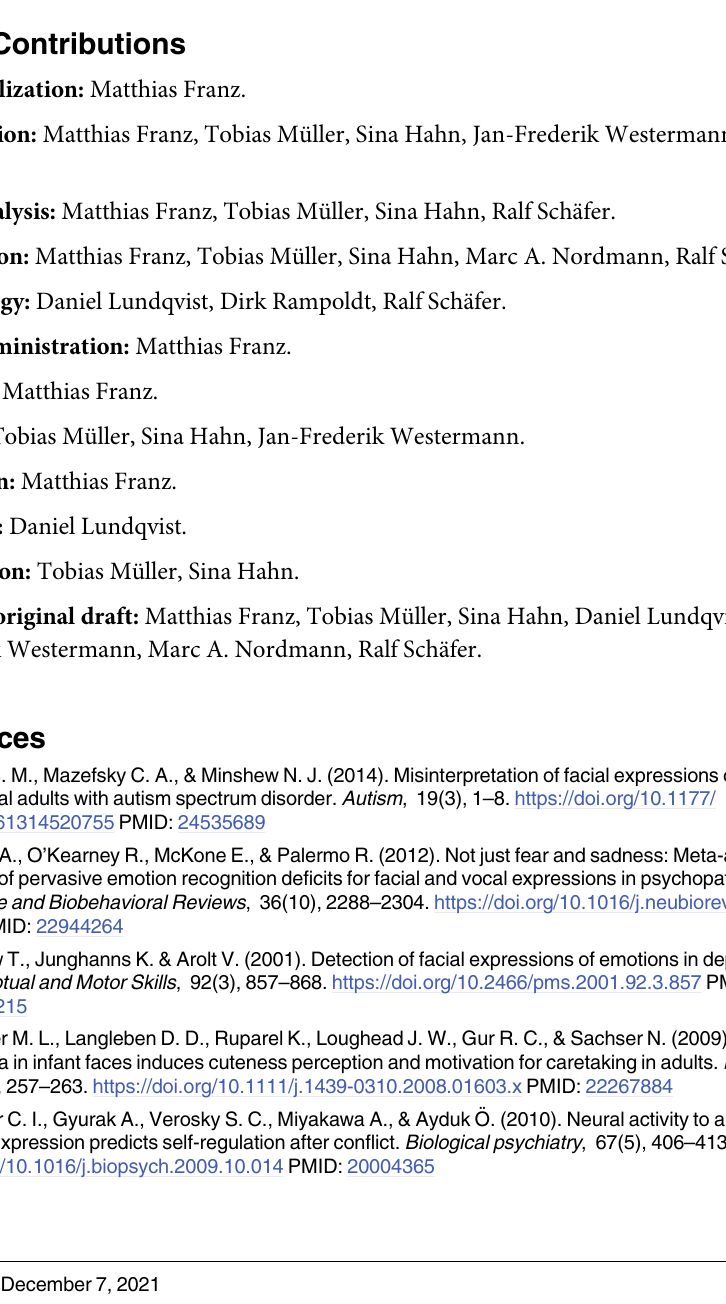
S1 Table. Rating of intensity of each basic affect and index of difficulty (range 0 to 5; dif- ference between the highest affect rating and the added four other affect ratings) of the 140 individual affect expressive portraits of children taking part in the online-rating. Gray = Portraits were excluded due to negative index of difficulty. Yellow: highest rating of intensity. SD = standard deviation. f = female. m =